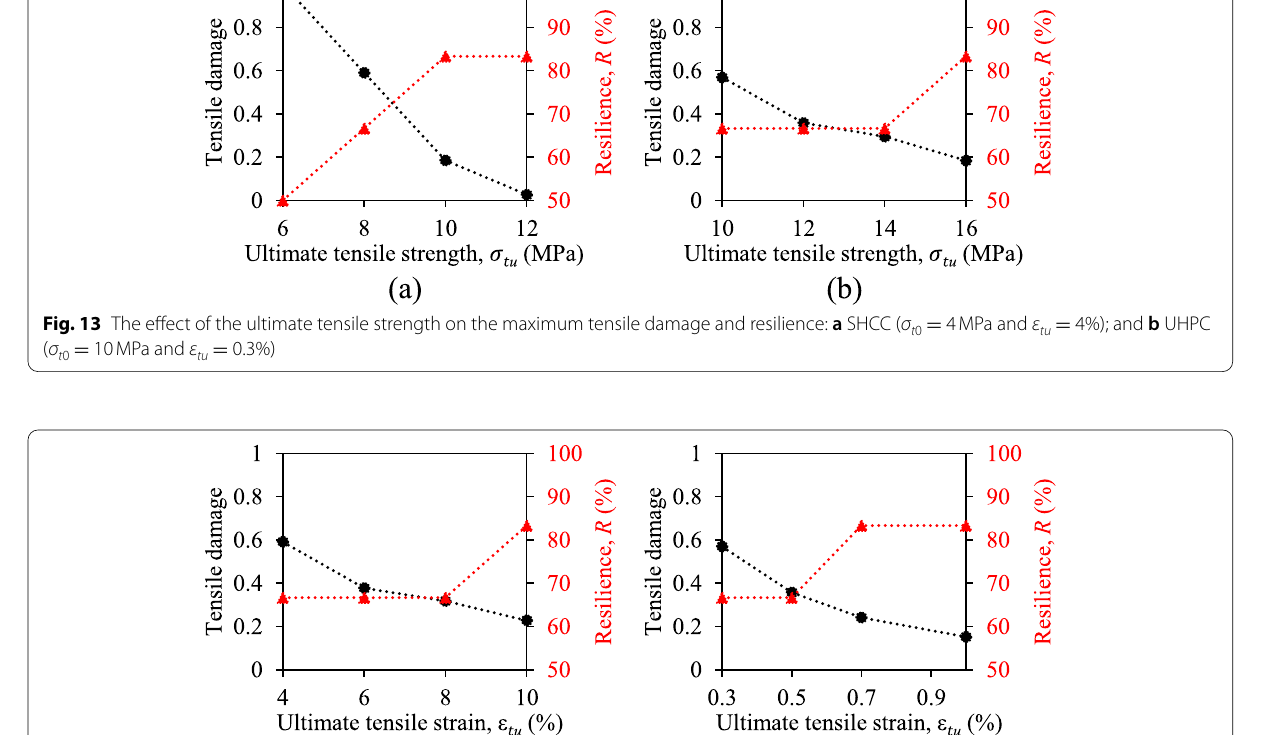
Fig. 14 The effect of tensile strain capacity on the maximum tensile damage and resilience: a SHCC ( σ t 0 10 MPa and σ tu 10 =